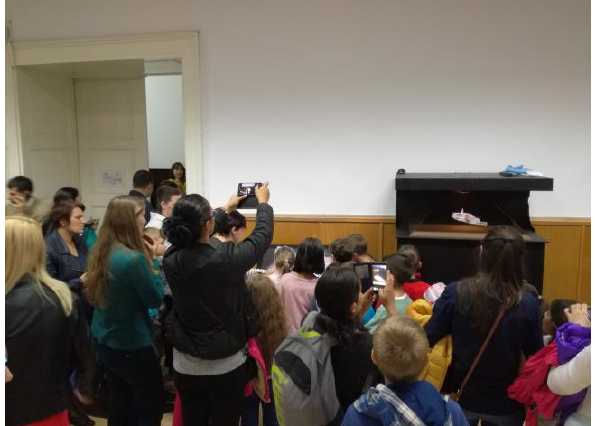
Figure 1. Users testing various systems during Researchers’ Night